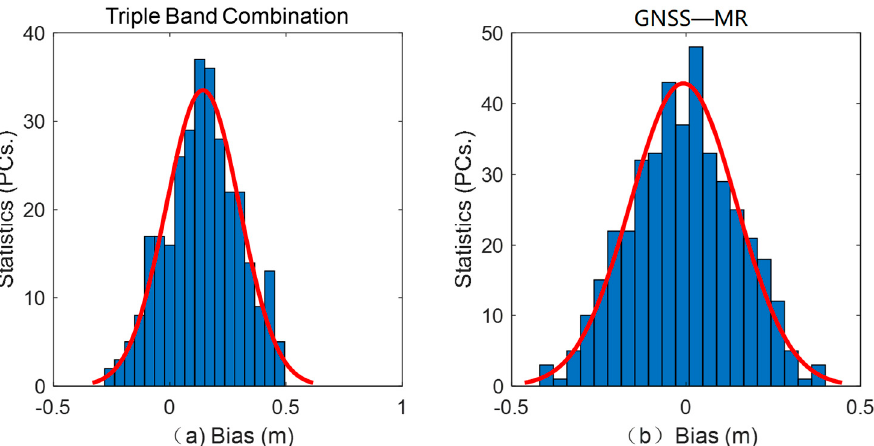
Figure 8. The histogram of the statistical distribution of the tidal deviation of ( a ) triple-frequency combined inversion of the tide level method and ( b ) the GNSS-MR inversion.